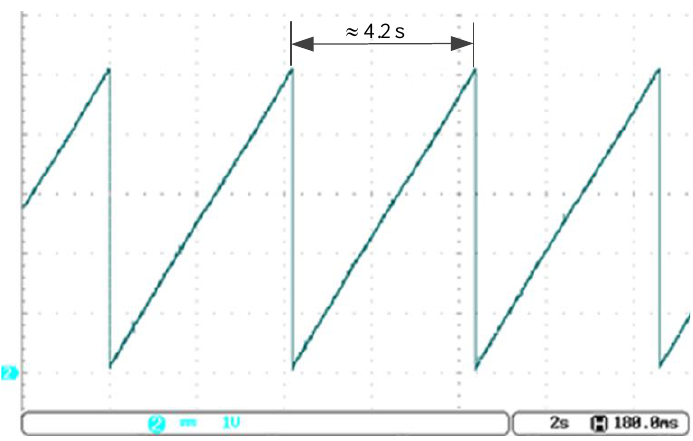
Figure 19. The position responses for the speed command of 3 rpm.